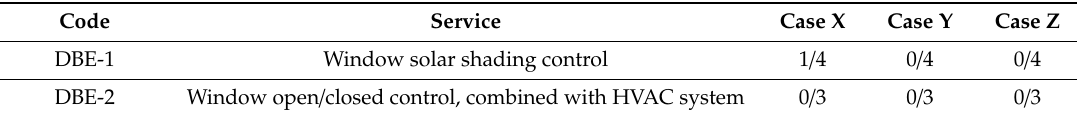
Table 8. The functionality levels in the main domain of dynamic building envelope (DBE).